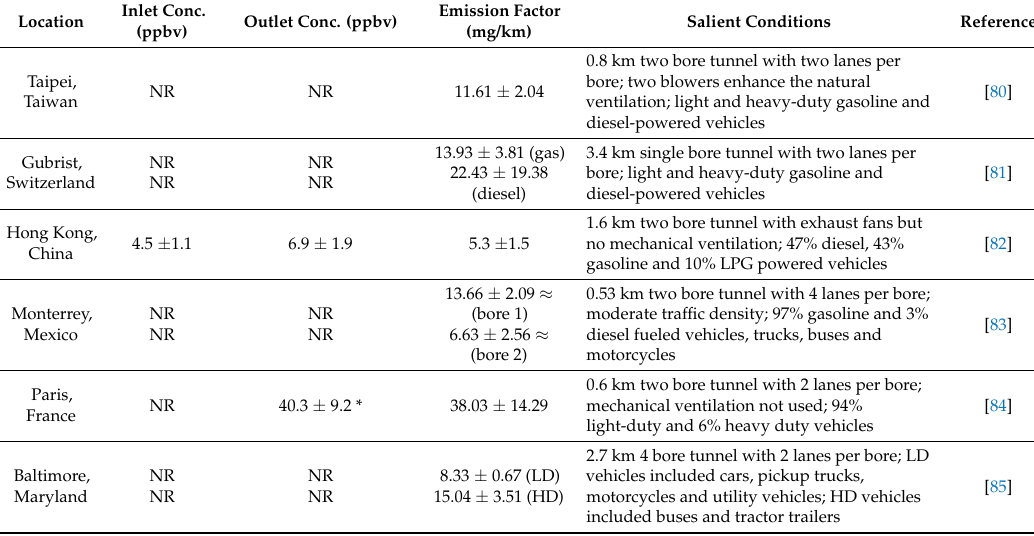
Table 3. Propylene concentrations and exhaust emission factors found in tunnel